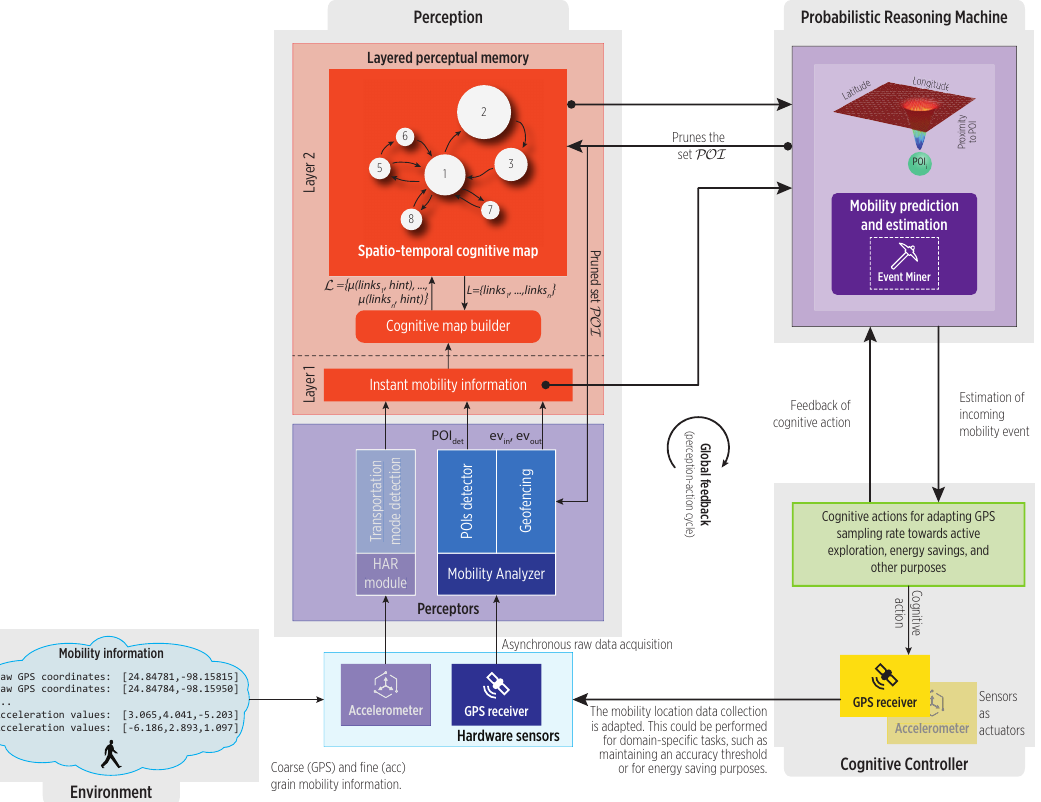
Figure 1. The architecture of the reference CDS for on-device mobility detection, learning and understanding (enhanced from [13]). the perception block constructs the cognitive map to summarize mobility for further exploitation and analysis in the